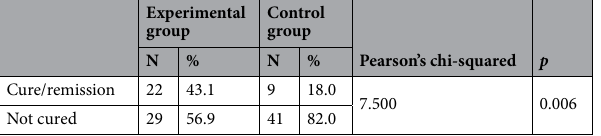
Table 2. Cut-off abscess cure rate on day-5 of treatment in the two